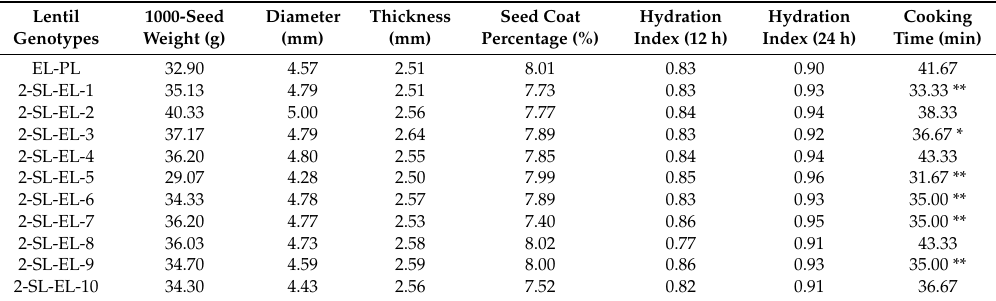
Table 2. Agronomical, morphological, seed coat %, hydration index, and cooking time of the parental landrace “Elassona” and second-generation sister lines originating from “Elassona”. Lentil